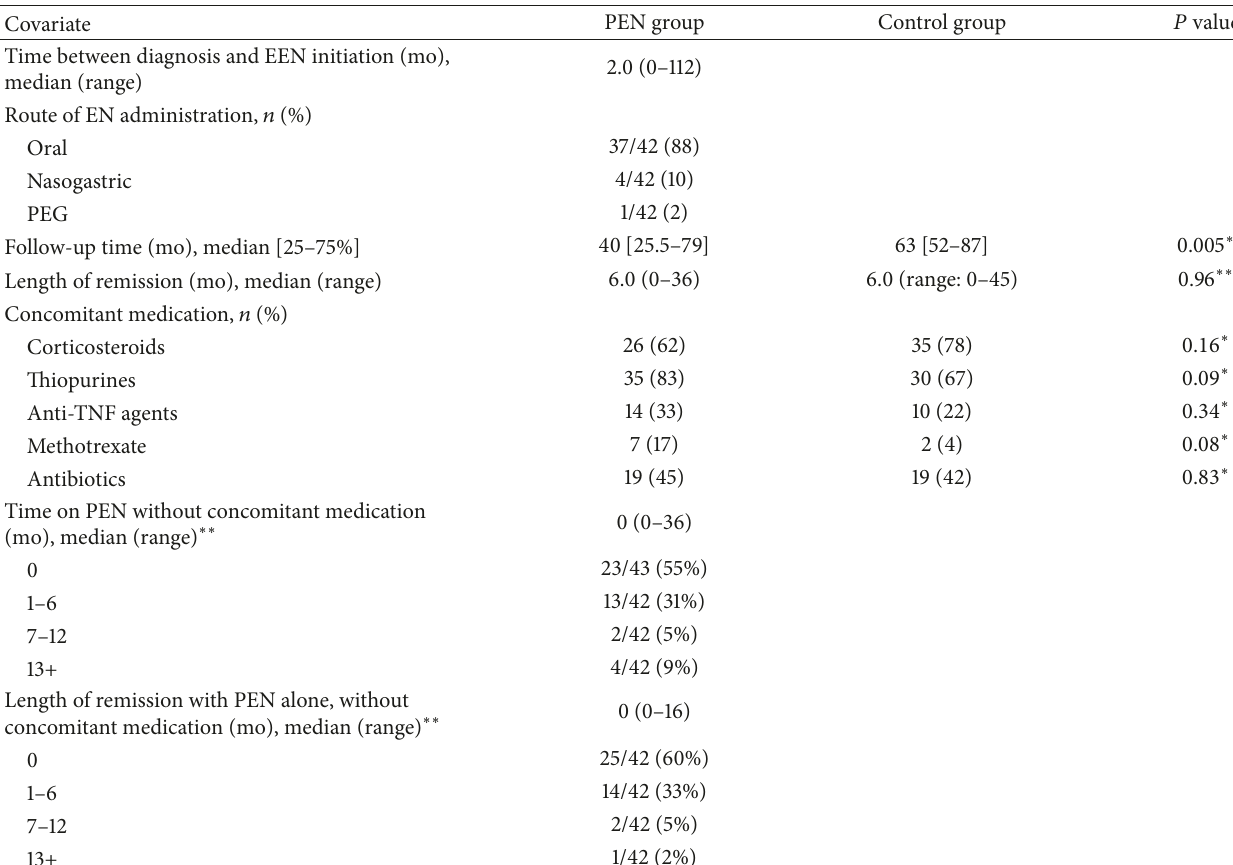
Table 2: Remission rates and concomitant